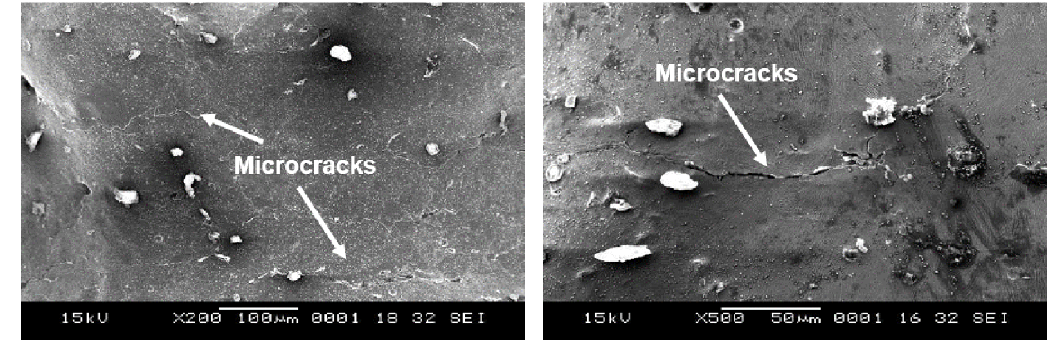
Figure 12. Formation of microcracks with sandblasting followed by electropolishing (experiment 1B).